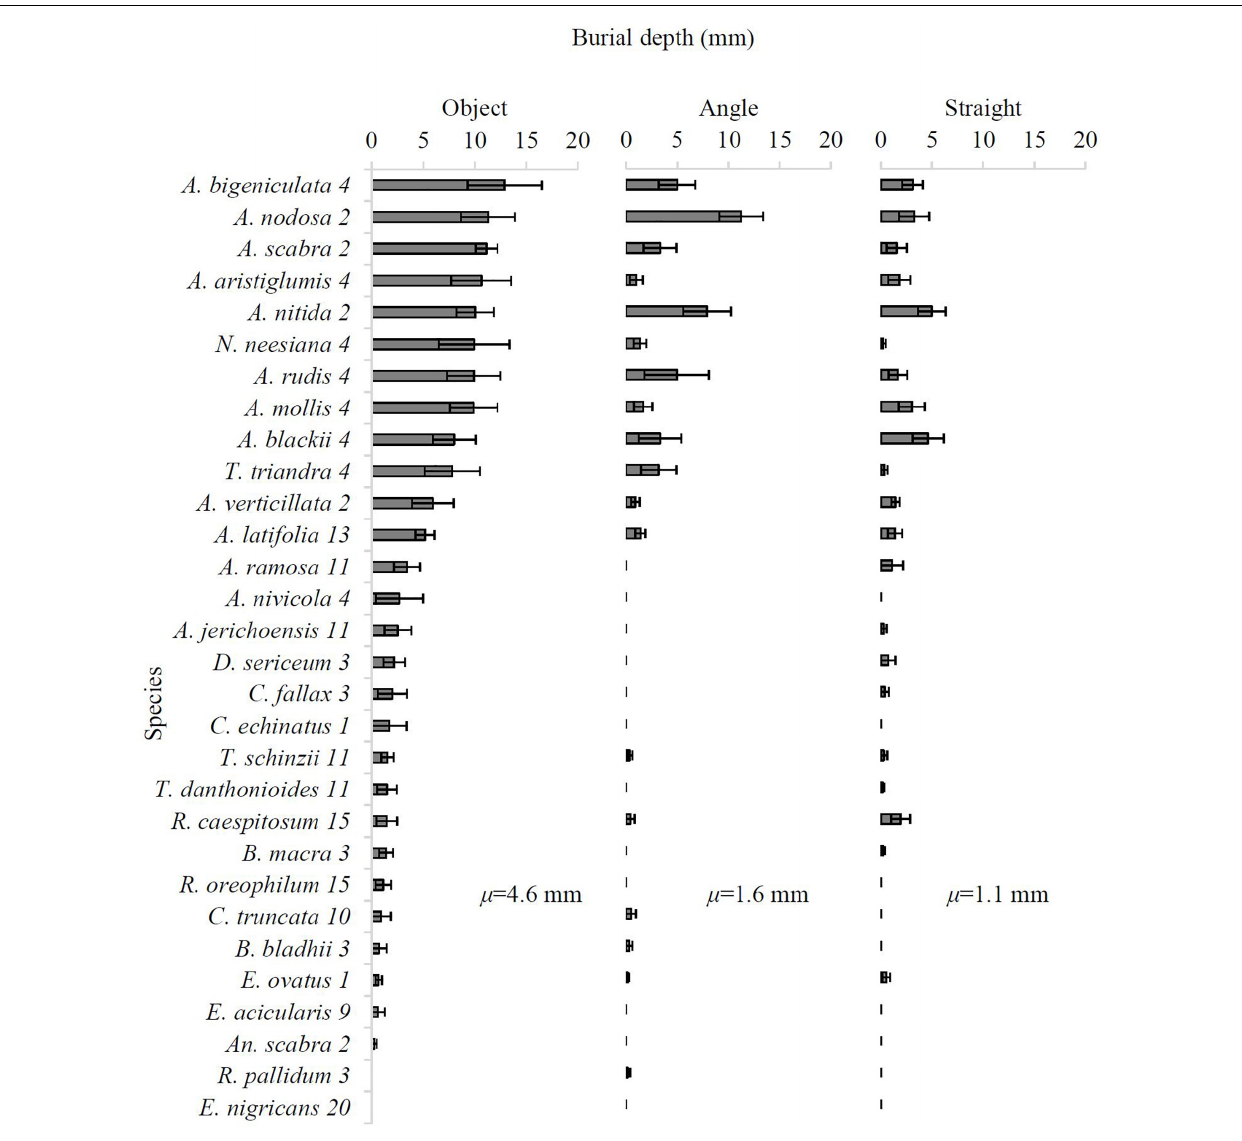
Figure 7 ). While only 38% of T. triandra diaspores lodged,